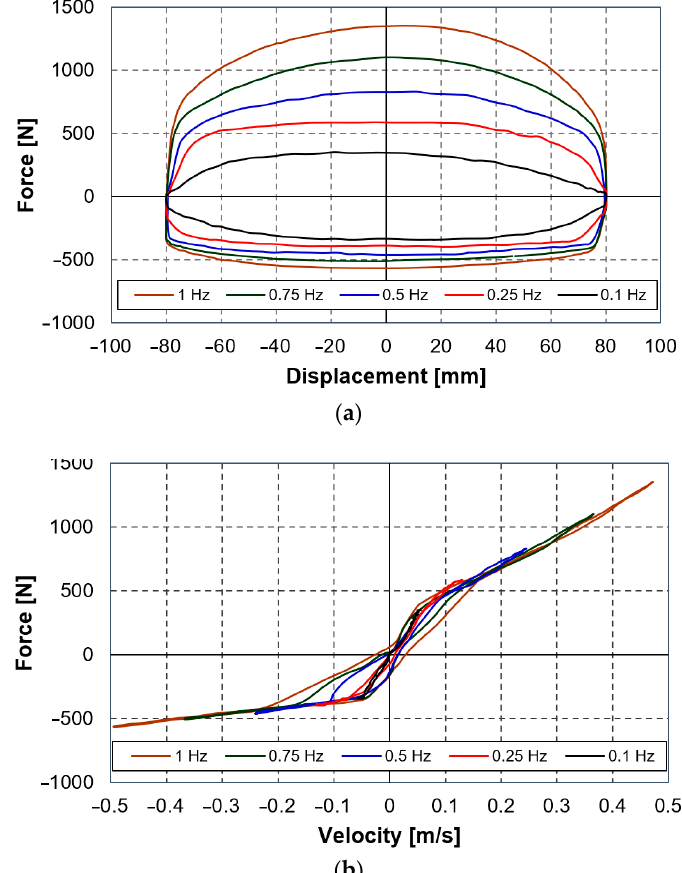
Figure 2. Characteristics of the shock absorber: ( a ) force–displacement; ( b ) force–velocity. For low velocity values (in the range of − 0.05 to 0.05 m/s), the average damping coef- ficient was 6.8 kN·s/m. The asymmetry coefficient (the relative amounts of bump and re- bound damping) for the shock absorber under consideration was approximately 64%. The values of the damping coefficients in each operating range are summarised in Table 1.